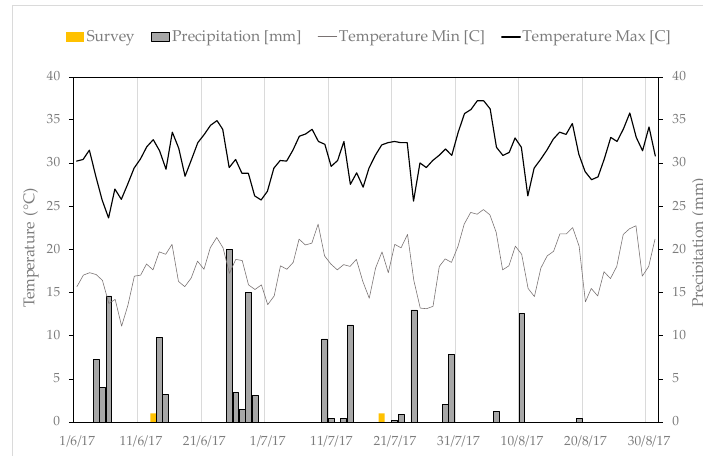
Figure 2. Precipitation and temperature daily data collected at the agrometeorological station of Erbusco, during the experimental period from June to August 2017.